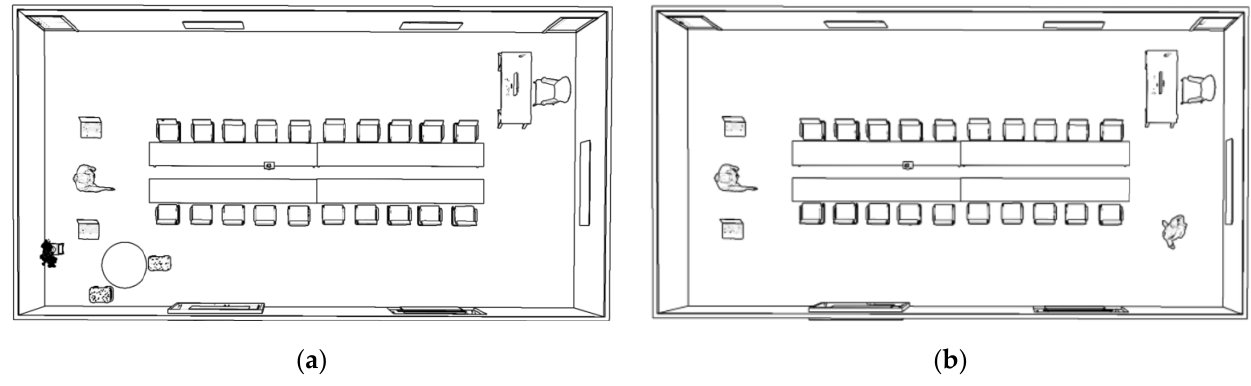
Figure 17. Environmental design: ( a ) Static environment. ( b ) Dynamic environment.